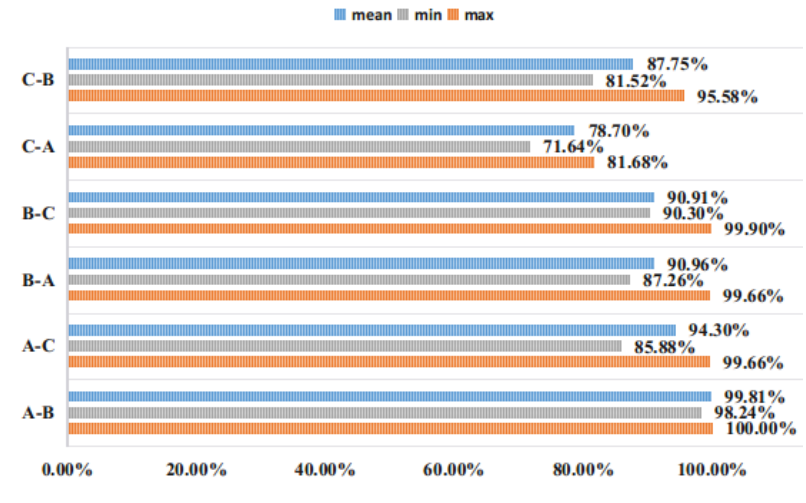
Figure 11. Fan end data test.